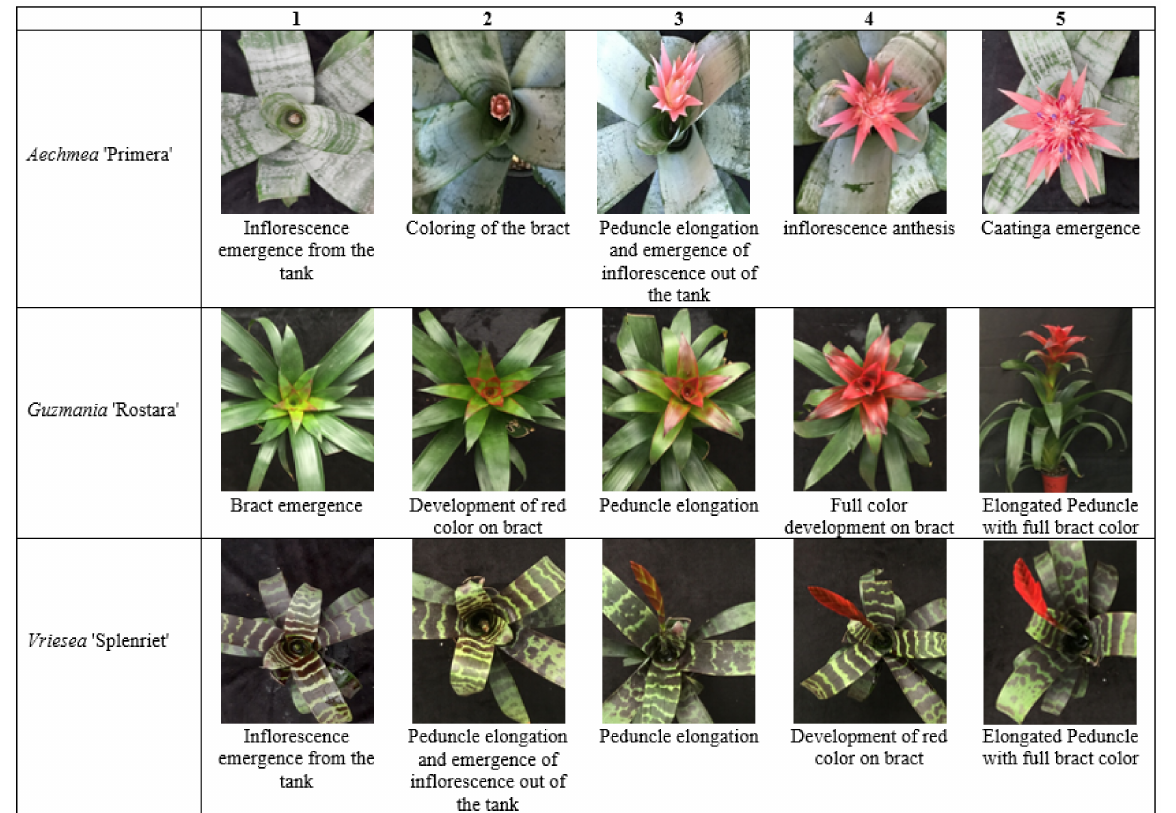
Figure 1. Scale characterizing inflorescence development in the three species under